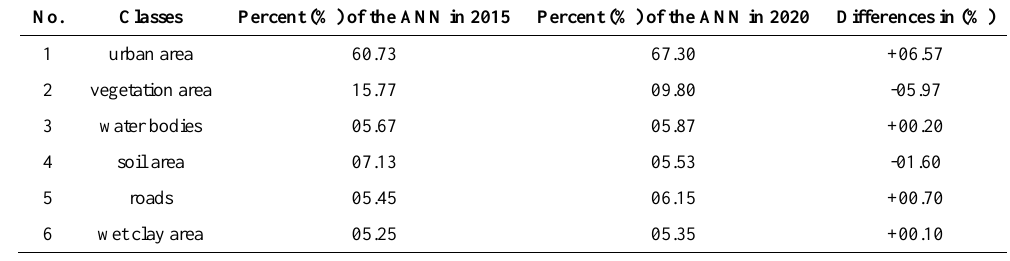
Table 6. Results of the LC classes using the combined images of 2015 and 2020